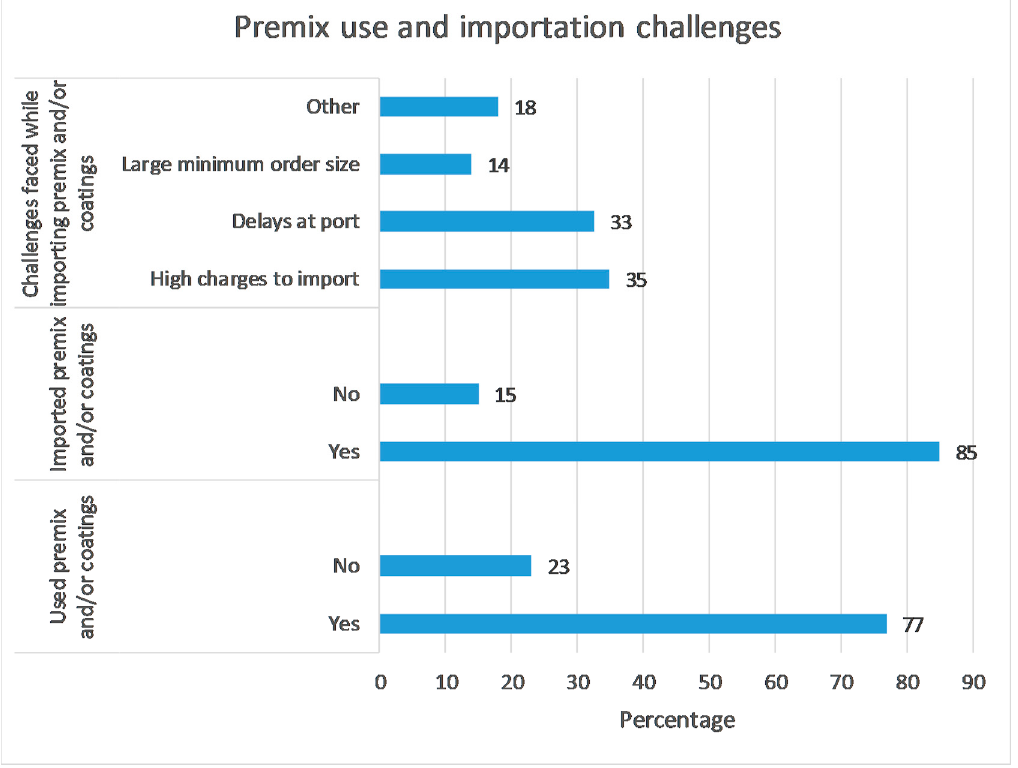
Figure 5. Premix/coatings usage, importation, and challenges by percentage. Figure 5. Premix / coatings usage, importation, and challenges by